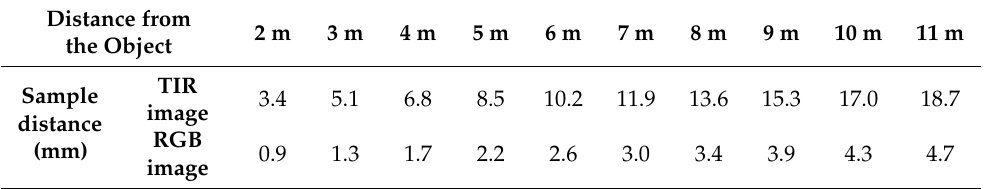
Table 3. Approximate sample distances for images captured from different distances. Distance